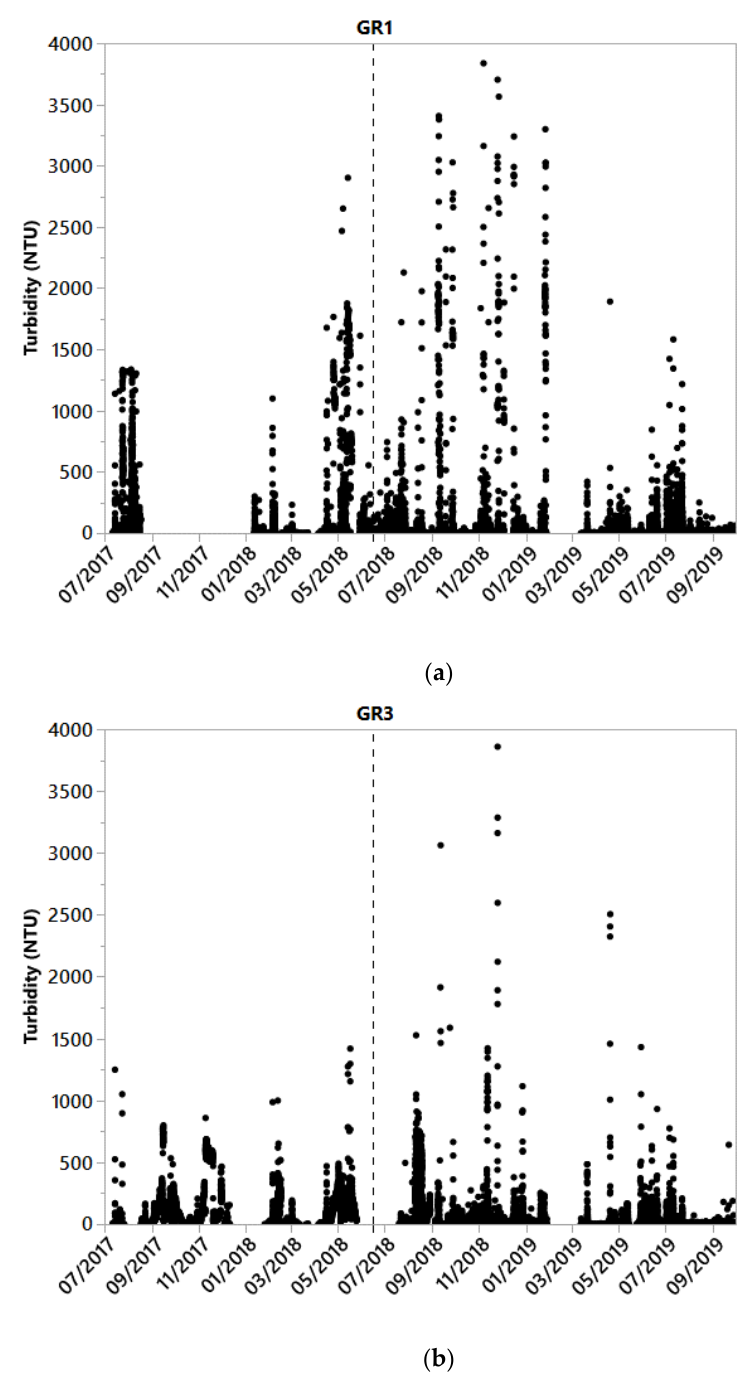
Figure 7. Time series plot of turbidity at ( a ) GR1 and ( b ) GR3. Gaps in the series are times when fouling occurred or the sonde was in for maintenance. The dashed line represents when in-stream construction began on 15 June 2018.